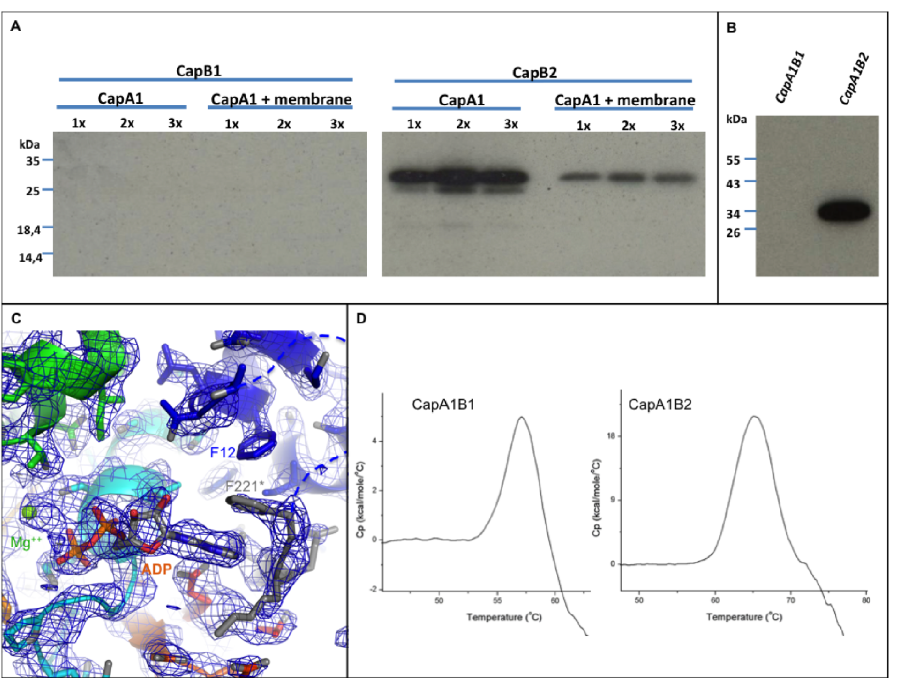
Figure 5. Functional and structural characterization of CapA1B1. A - CapB1 (left panel) and CapB2 (right panel) activation assays using either purified full length 6xHis-CapA1-FL (6xHis-CapA1-FL) or membrane fractions enriched with full-length 6xHis-CapA1-FL. An increasing concentration of CapA1 was used as indicated. CapB1 and CapB2 autophosphorylation was determined after incubation with radioactive ATP, SDS-PAGE separation and autoradiography. B - Phosphorylation of CapA1B1 and CapA1B2 during overexpression in E. coli . CapA1B1 and CapA1B2 purified from E. coli were analyzed by SDS-PAGE and transferred onto a PVDP membrane. Their phosphorylation was revealed by immunoblotting using the anti- phosphotyrosine antibody 4G-10 and the secondary antibody HRP conjugate after direct film exposure. C - Electron density of the ADP-Mg molecule bound in the CapA1B1 active site. (2Fo-Fc) map contoured at 1 s . The bound nucleotide and the residues involved in nucleotide and Mg 2 + binding are shown in sticks. D - Stability of CapA1B1. Differential Scanning Calorimetry of CapA1B1 compared with